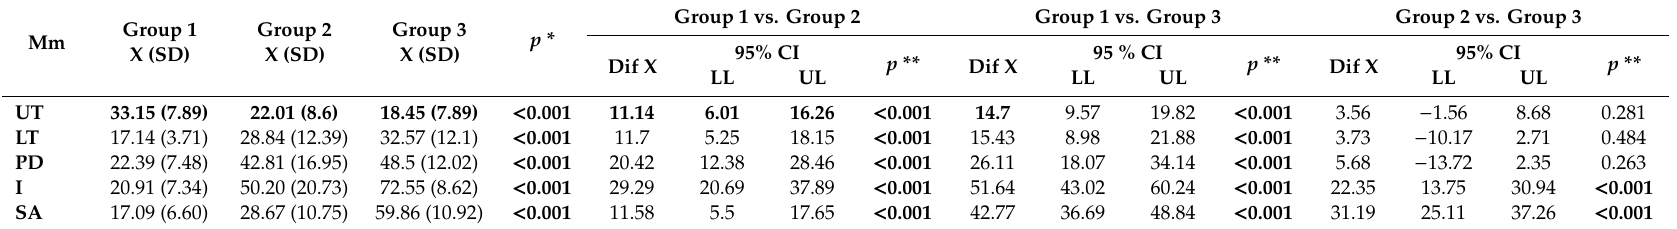
Table 7. The amplitude of muscle activity (RMS%). External rotation